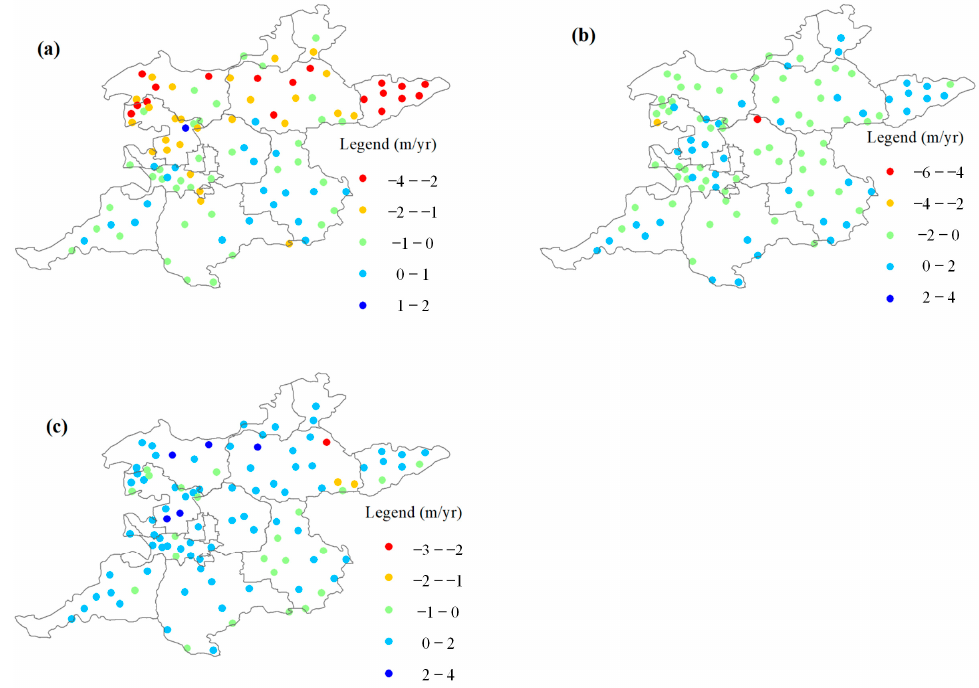
Figure 3. The spatial distribution of △ GWL trends during ( a ) 2005–2011, ( b ) 2012–2014, and ( c ) 2015–2018, respectively.